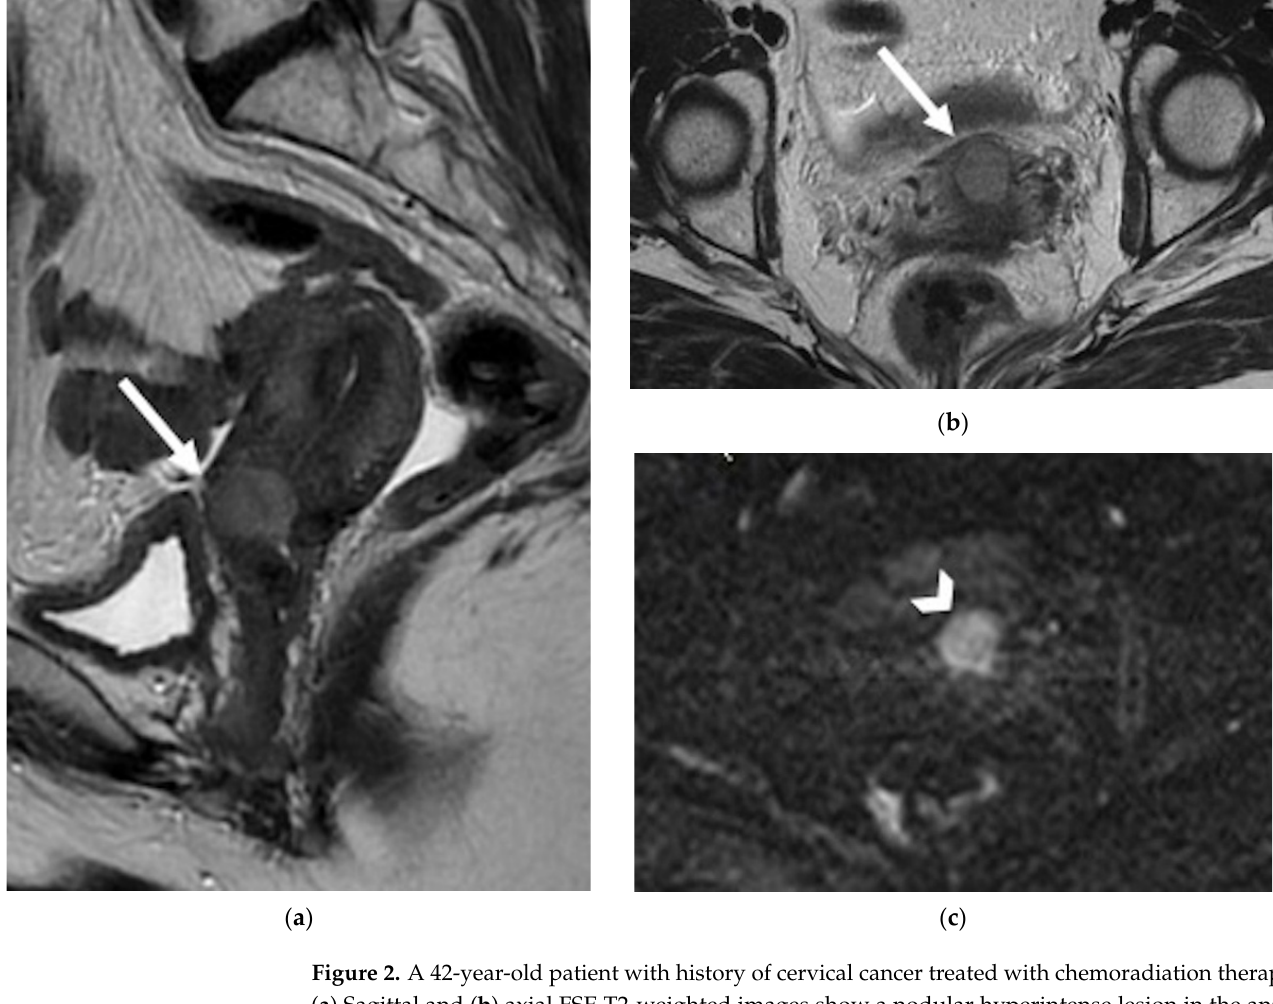
( c ) Figure 4. A 57-year-old patient who underwent radical hysterectomy with bilateral salpingo–oo- phorectomy for cervical cancer. ( a ) Sagittal and ( b ) axial FSE T2-weighted images show a nodular hyperintense lesion in the vaginal cuff (arrows), consistence with relapse. ( c ) Diffusion-weighted image demonstrates highly restricted diffusion of the lesion (arrowhead) in relation to hypercellu- larity. On MRI, tumor recurrence may appear as a region of intermediate-to-high signal in- tensity on T2WI, on a background of established low-signal-intensity change reflecting radiation-induced fibrosis [23] (Figure 2). Relapse vaginal cuff lesions may appear as a mass-like tumor or as an infiltration along the vaginal wall, but they may also occur as skip lesions involving the distal vagina. On T2WI, tumor recurrence is seen as the loss of the linear, low-signal-intensity of the vaginal vault with an associated intermediate-to-high signal intensity soft-tissue mass [25] (Figure 4). Post-treatment fibrotic changes may alter the linear appearance of the vaginal vault, with adhesions between the vaginal vault and surrounding organs (i.e., rectum, bladder). The use of intravenous gadolinium contrast medium can help distinguish be- tween recurrent disease versus post-treatment fibrosis, with maximum tumor enhance- ment occurring between 45 and 90 s after contrast administration [26]. On DWI, an active tumor appears as an area with a hyperintense signal on high-b-value images, associated with lower apparent diffusion coefficient (ADC) values on the ADC maps. Recurrent tu- mor may be recognized on contrast enhanced CT scans as a soft-tissue mass with early enhancement. However, MR imaging is superior to CT for delineating recurrent tumors because it provides superior soft-tissue contrast [27]. Recurrent pelvic CC appears as a focal area of increase FDG-uptake on 18F-FDG PET/CT images.